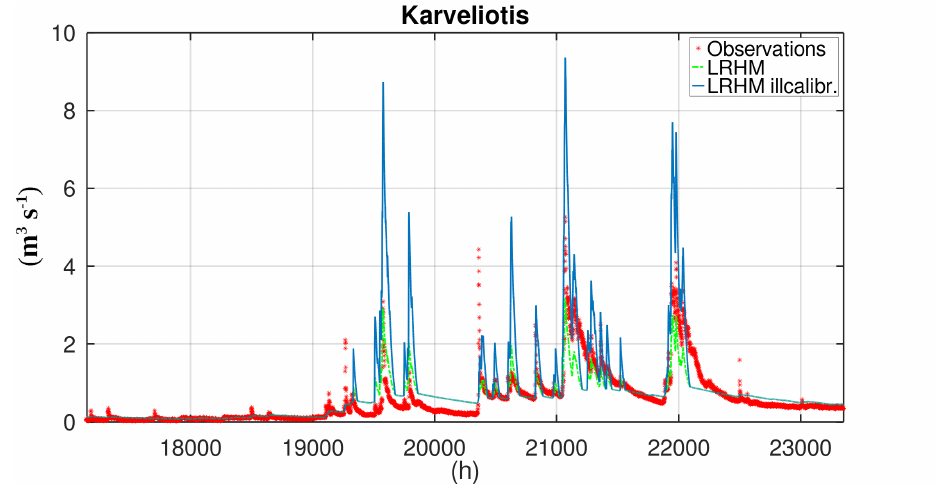
Figure 4. Application of LRHM in Karveliotis during its calibration, corresponding intentionally ill-calibrated LRHM model and observations.